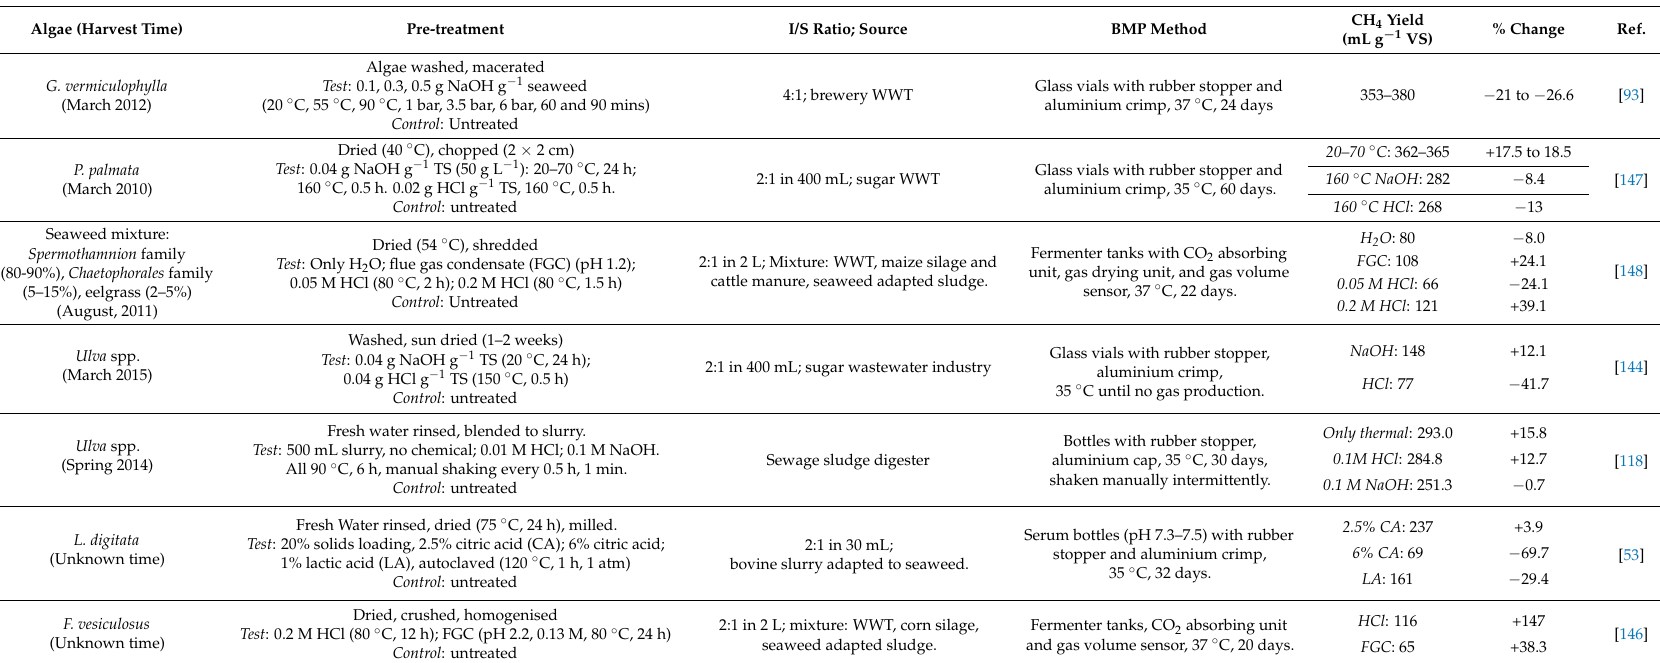
Table 6. Methane yields following thermochemical pre-treatment of